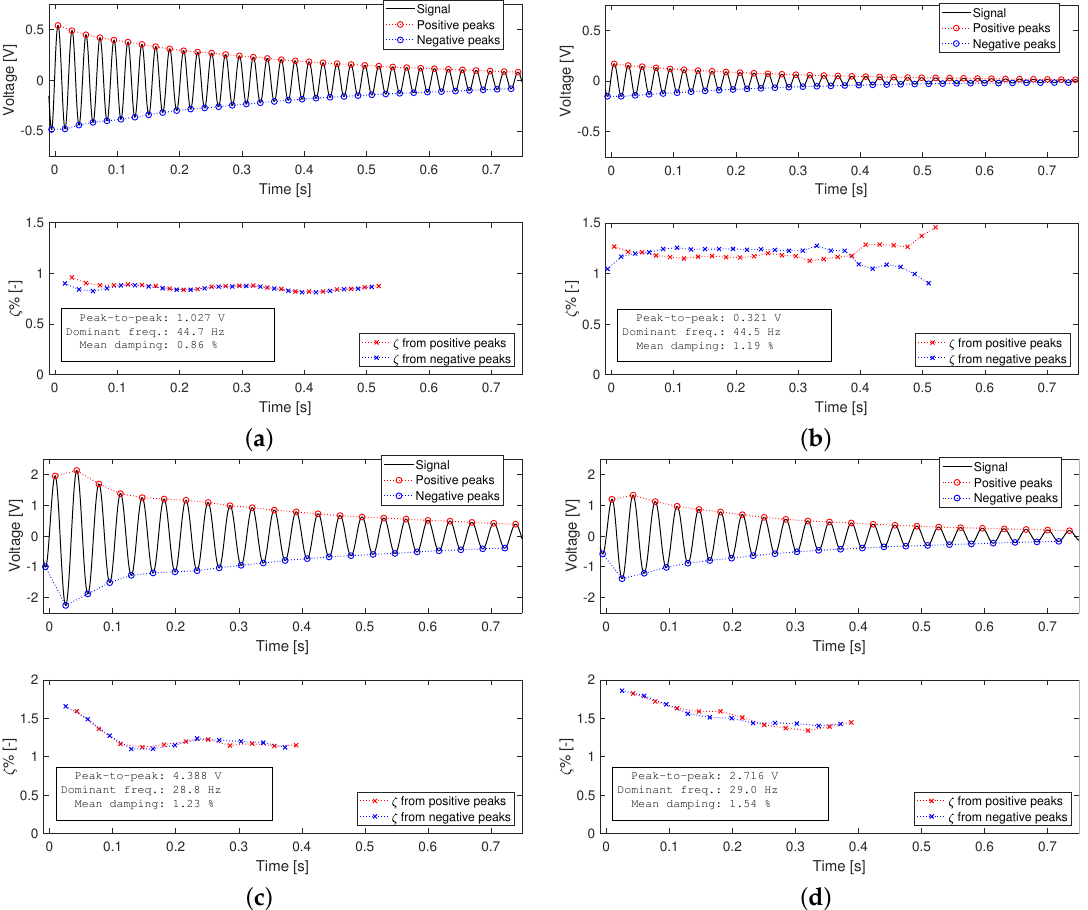
Figure 4. Analysis of the voltage signals. ( a ) Indoor tests, empty spoon; ( b ) outdoor tests, empty spoon; ( c ) indoor tests, full spoon; ( d ) outdoor tests, full